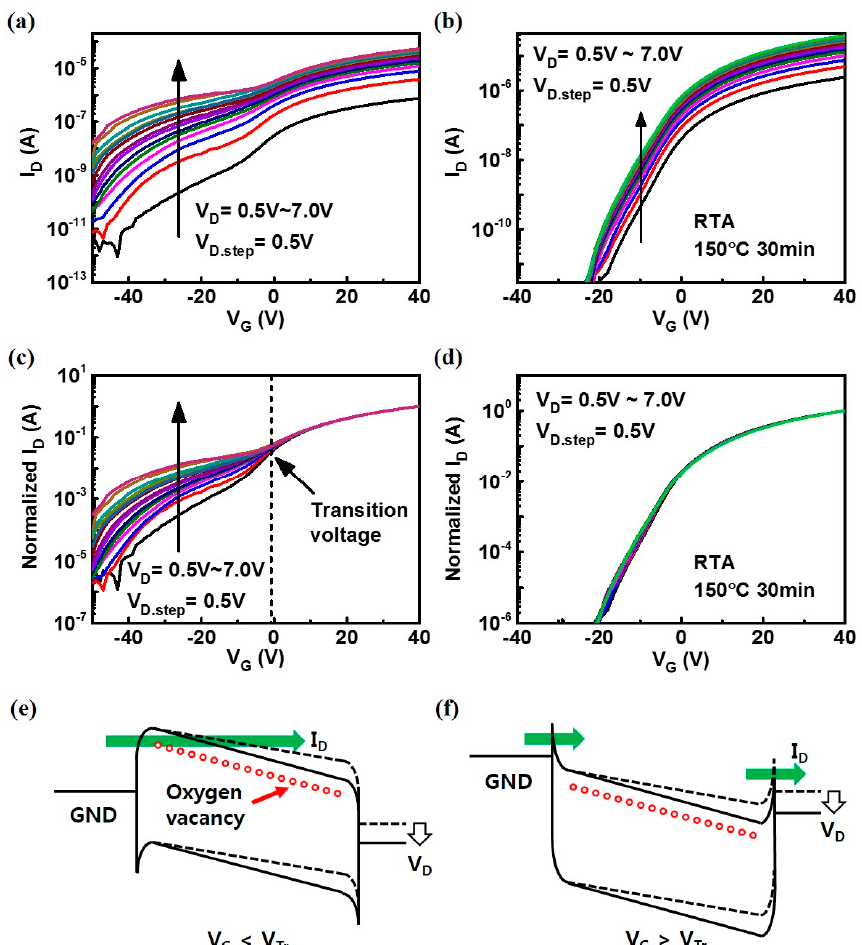
Figure 2. I D –V G transfer curves measured at different V D ( a ) after low vacuum treatment ( b ) after RTA in oxygen ambient (150 °C for 30 min); ( c , d ) I D –V G transfer curves of ( a ) and ( b ), respectively, normalized with respect to I D at V G = 40 V; ( e ) Schematic band diagram for the case having V G below the transition voltage (V Tr ). Trap-assisted tunneling (TAT) current (green arrow) increased via an oxygen vacancy level near the conduction band of ZnO; ( f ) Schematic band diagram for the case having V G above V Tr . The current (green arrow) flows through the Schottky barrier at source/channel and channel/drain without being affected by oxygen vacancies. The small red circles denote the expected energy level of oxygen vacancy.